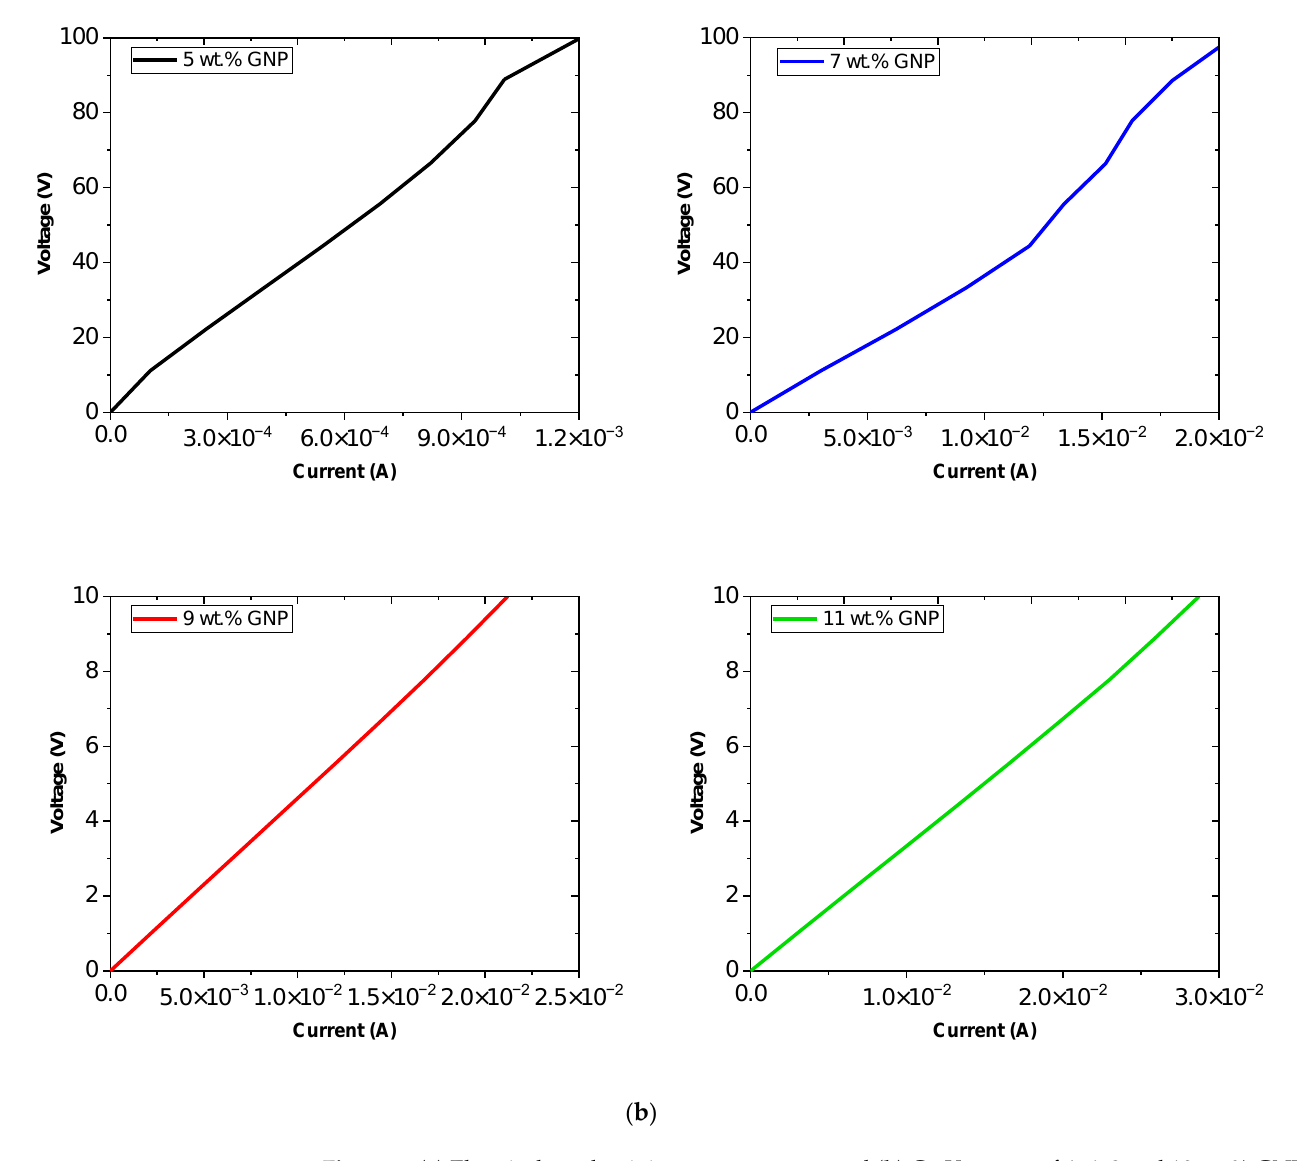
Figure 2. ( a ) Electrical conductivity measurements and ( b ) C−V curves of 4, 6, 8 and 10 wt.% GNP nanocomposites.